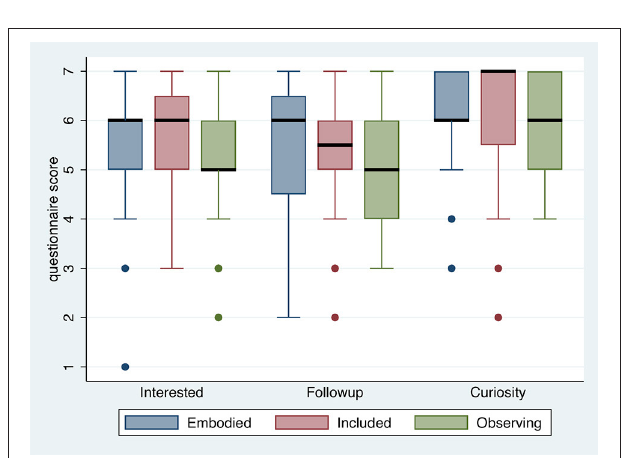
FIGURE 6 | Box plots for the Engagement